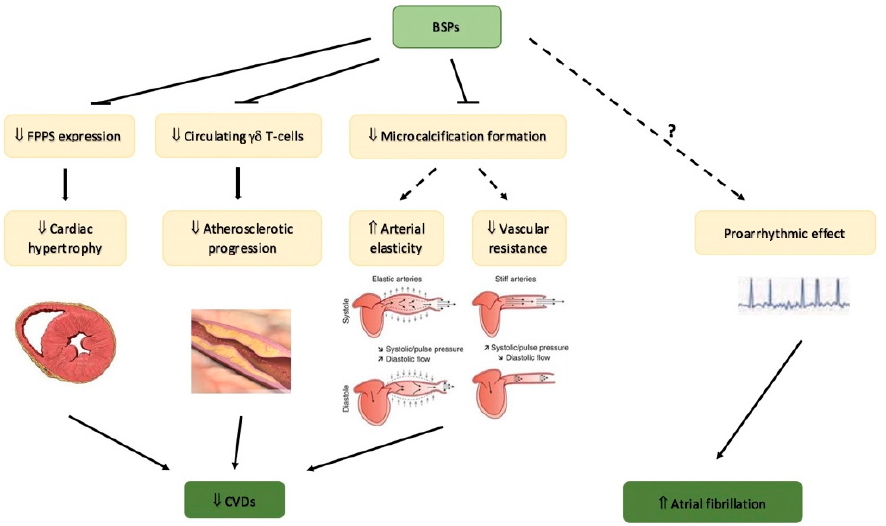
Figure 2. Potential mechanisms involved in the relationship between bisphosphonates (BSPs), cardiovascular diseases (CVDs), and arrhythmias, according to data from preclinical studies, are shown. BSPs have shown to reduce cardiac hypertrophy, atherosclerotic plaque, and vascular re- sistance and to improve arterial elasticity; potential mechanisms of the proarrhythmic effect of BSPs are not yet clear. FPPS = farnesyl pyrophosphate synthase. Dotted arrows indicate uncer- tain mechanism and relationship, and arrows next to the words show the increase or decrease. “?” indicates uncertain mechanisms and